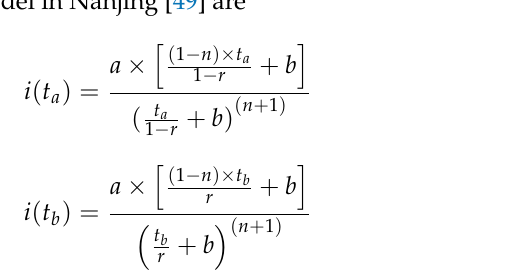
Figure 8. Facilities layout and design workflow diagram for S4.